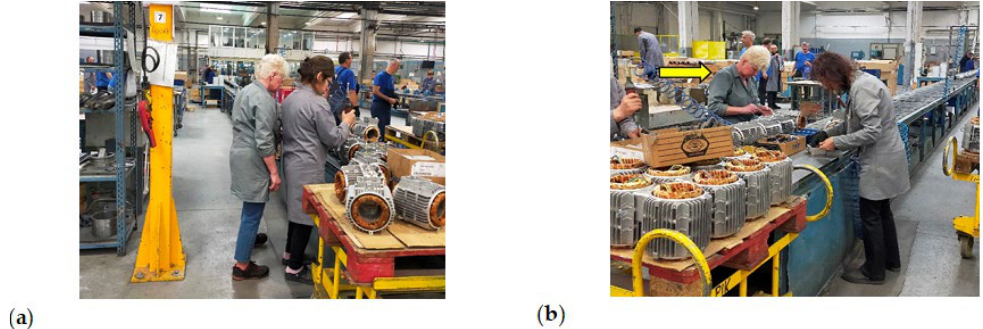
Figure 3. ( a ) Training through the method of observation; ( b ) The new operator working on the assembly conveyor.